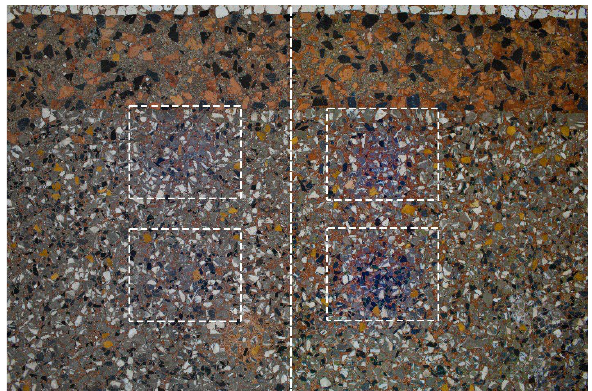
Figure 6 :picture with the four blue-tinged areas, corresponding to the headlights, characterised by a colour tending towards blue. The image (original in the left-hand side) has been modified in the right-hand side to highlight the